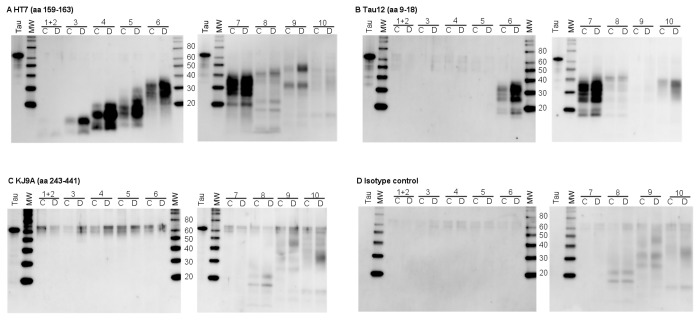
Detection of tau fragments in human CSF.Human control and AD CSF subjected to RP-HPLC, fractions collected and run on SDS-PAGE gels followed by western-blotting with different tau antibodies. A) HT7 (mid domain antibody). B) Tau 12 (N-terminal antibody). C) K9JA (C-terminal microtubule repeat domain antibody). D) IgG1 isotype control. On each blot, human recombinant tau441 (tau) is included in lane 1 and molecular weight markers (mw) in lane 2 followed by the HPLC fractions from 1 to 6 or HPLC fractions 7 to 11. Fractions 1 and 2 were pooled and run as a single sample, while fractions 3-10 were run as individual samples. Control CSF (C) and AD CSF (D) samples for each fraction were run side by side for comparison.